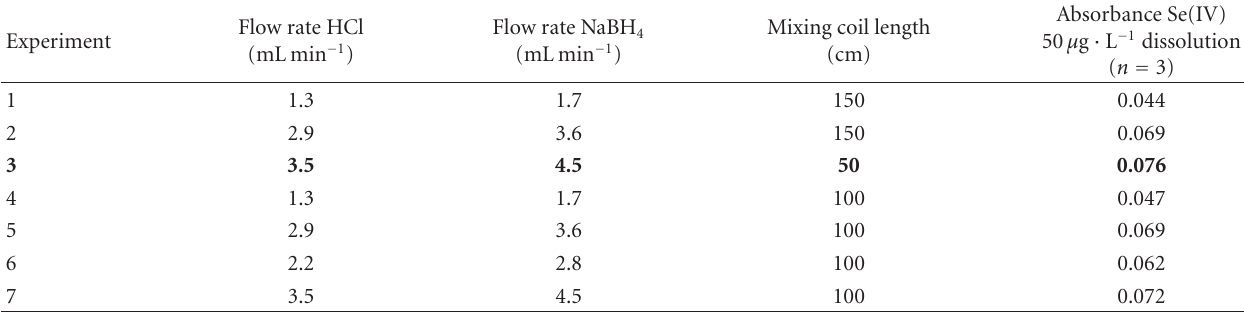
Table 1: Influence of the FIA system variables: multivariate